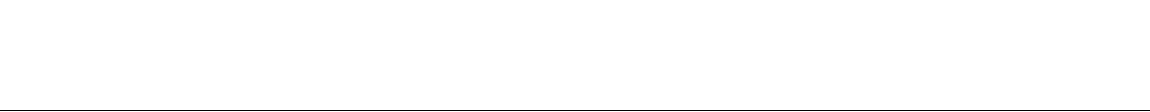
TABLE 4 | Historical records of earthquake damage due to 6 strong M8 earthquakes in or around China ’ s Loess Plateau (Gu, 1983). Historical earthquake Phrases that appear numerous times in records of earthquake geological